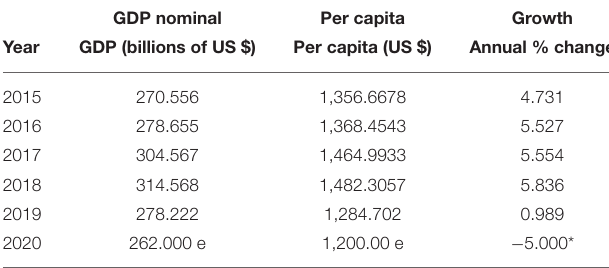
Pakistan dropped the interest rate to 7% on bank deposits in Mid- TABLE 4 | GDP, Per capita income, and annual %-change in growth.